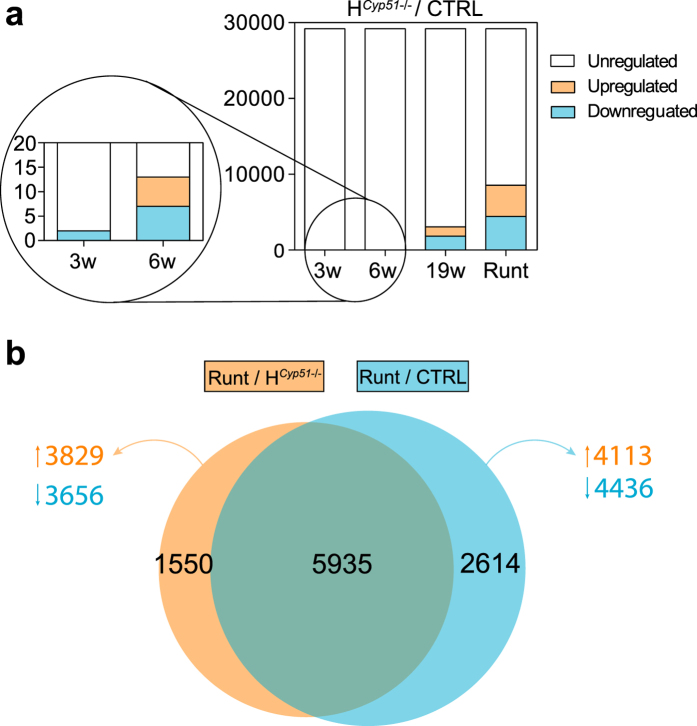
Hepatocyte Cyp51 disruption leads to progressive metabolic disruption.(a) A stacked column plot with numbers of differentially expressed genes comparing HCyp51−/− and control (CTRL) mice on the wild type background for a given age. Runts (5–7 weeks) were compared to 6-week controls. Downregulated genes (blue), upregulated genes (orange), unchanged expression (white). (b) Venn diagram comparing the number of DE genes in runts vs. 6-week HCyp51−/− mice and runts vs. 6-week control mice; all on the wild type Cyp51 background. The size of the circles correlates to the number of DE genes. The adjacent numbers state the number of corresponding upregulated (orange) or downregulated (blue) DE genes. n = 4 (HCyp51−/−; CTRL); n = 6 (runts).